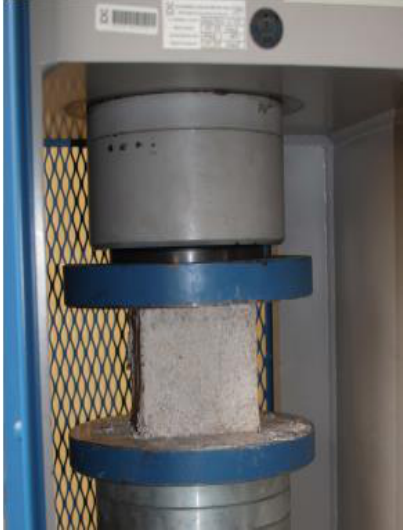
Figure 2. Test composite specimen in the device for determination of compressive strength.